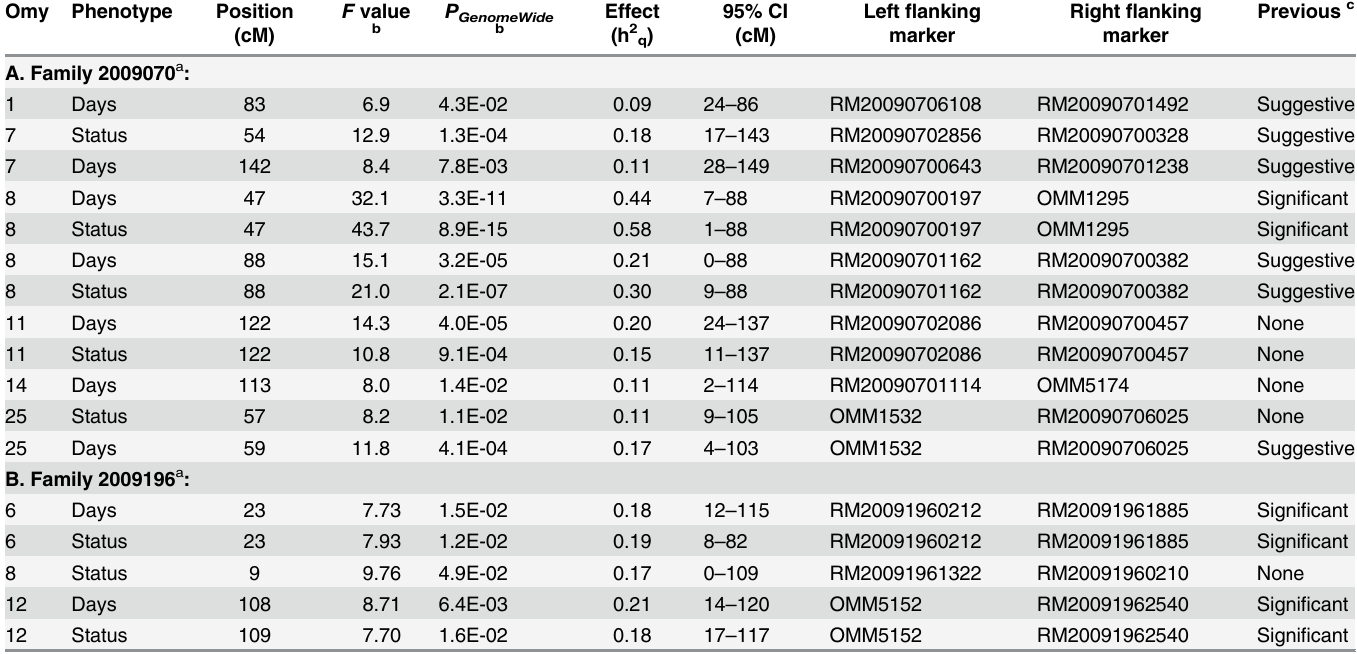
Table 2. QTL for BCWD resistance detected and validated using outbred population (TREE Model) analysis in two rainbow trout families for the phenotypes survival days (Days) and survival status (Status).